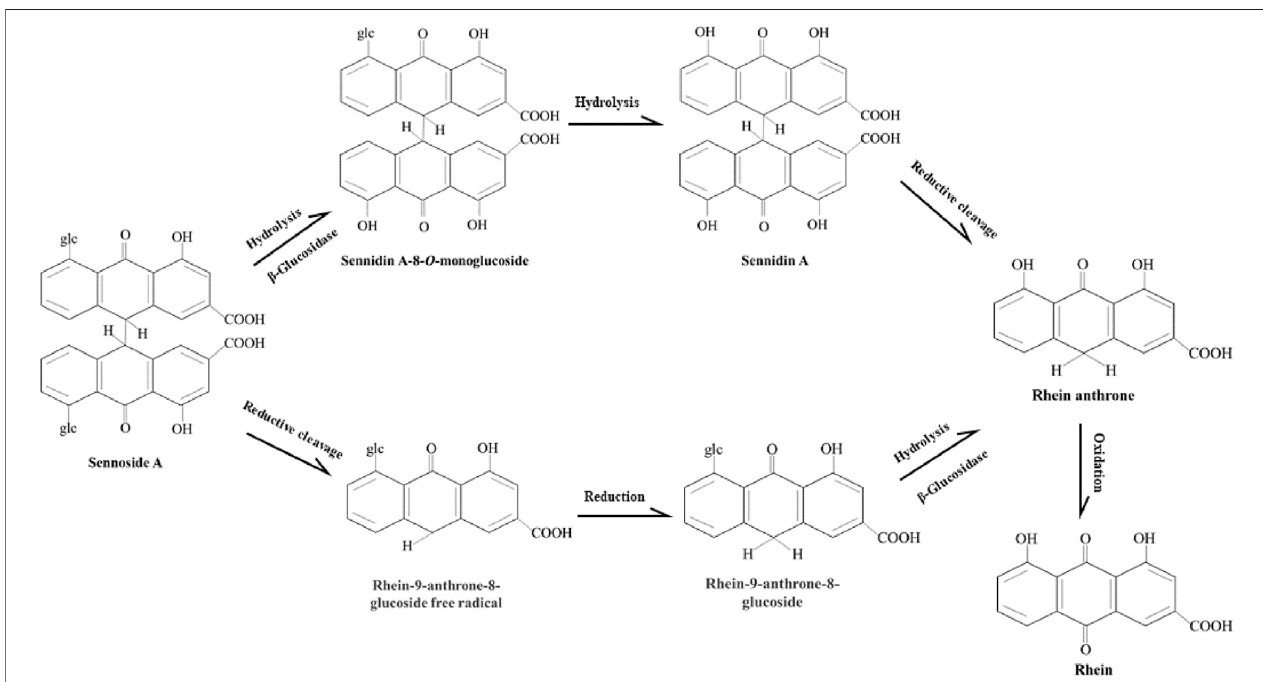
FIGURE 5| Proposed metabolism pathways ofsennosideA in large intestine. The metabolic pathways ofSA transforming torhein anthrone include the hydrolysis oftheO-linked sugarsbybacterial β -glucosidaseand thereductionoftheanthrone glucoside radical bybacterial reductase. Then rhein anthrone canbetransformedby oxidation into